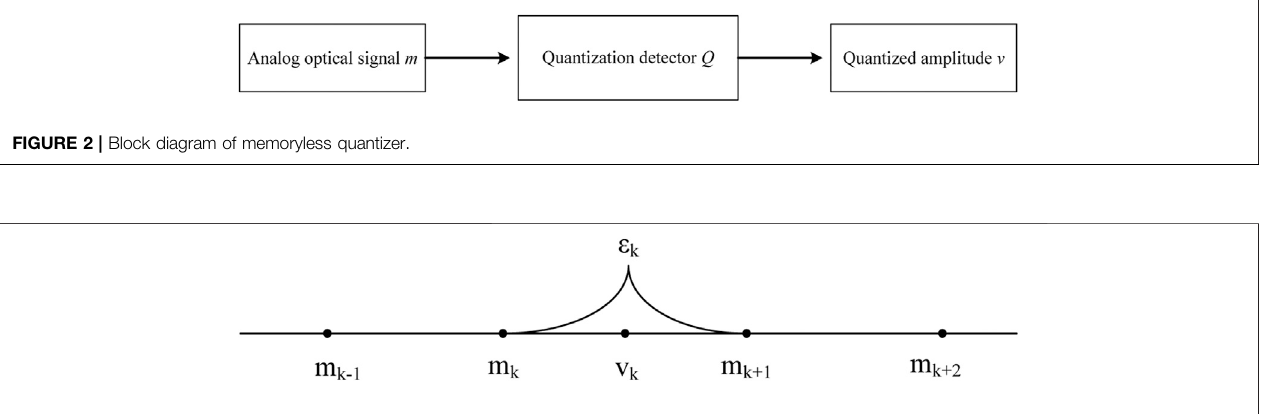
FIGURE 3 | Signal quantization interval.